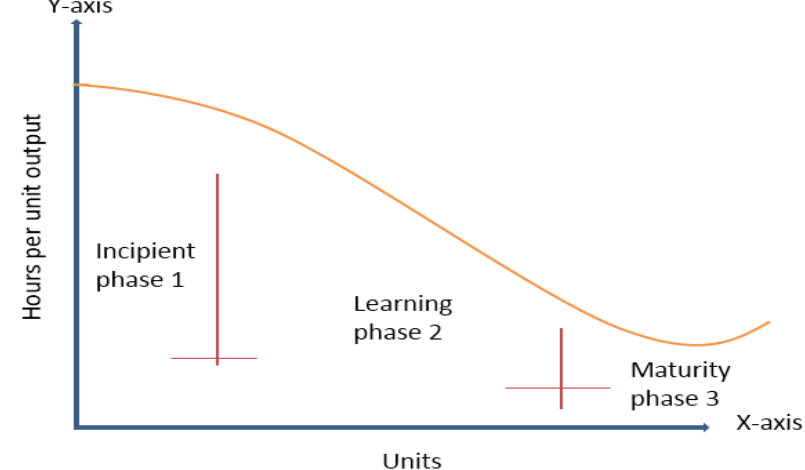
Figure 1. Learning stage.